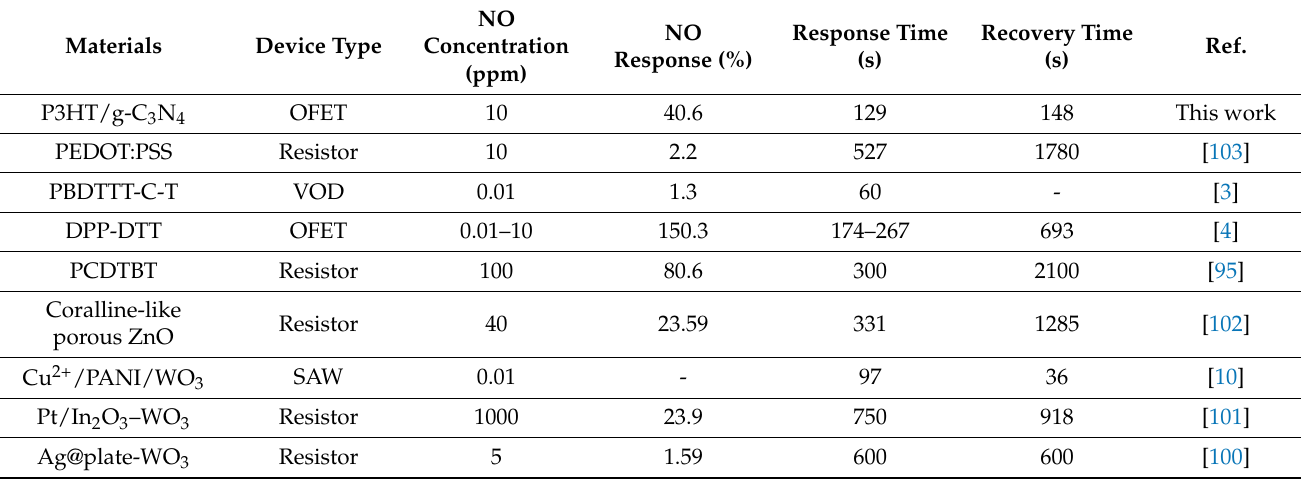
Table 1. Comparison of the NO sensing performances of the prepared P3HT/g-C 3 N 4 sensors and other sensors reported in the